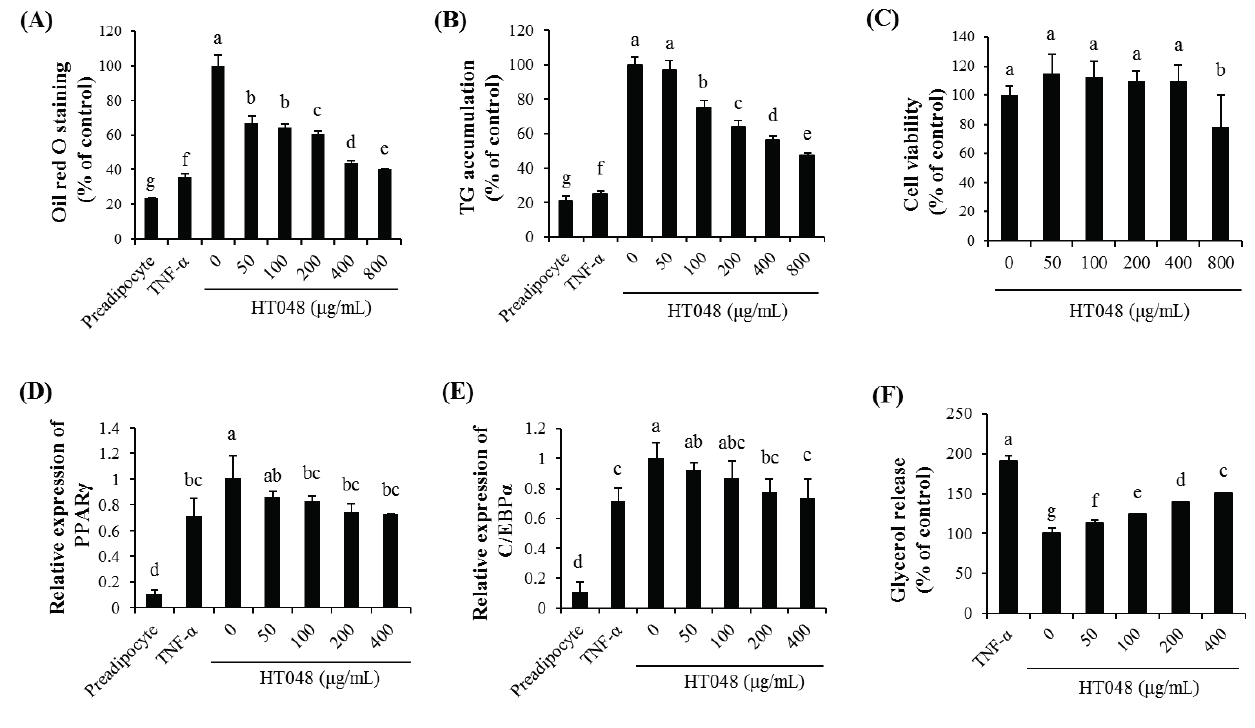
Figure 2. Effect of HT048 on cell viability and adipocyte differentiation of 3T3-L1 adipocyte. The 3T3-L1 adipocytes were incubated with or without HT048 of various concentrations for 24 h. Differentiated adipocytes were treated with or without HT048 of various concentrations. Oil Red O staining ( A ) and TG accumulation ( B ) of the 3T3-L1 cells were determeined. Growth rate was assessed by MTT assay ( C ). The expressions of the PPAR γ ( D ) and C/EBP α ( E ) were measured by qPCR. Glycerol release assay ( F ) of the 3T3-L1 cells were determined. Values are presented as the mean ± S.D. abcdefg Means not sharing common letters are significantly different among the groups at p <